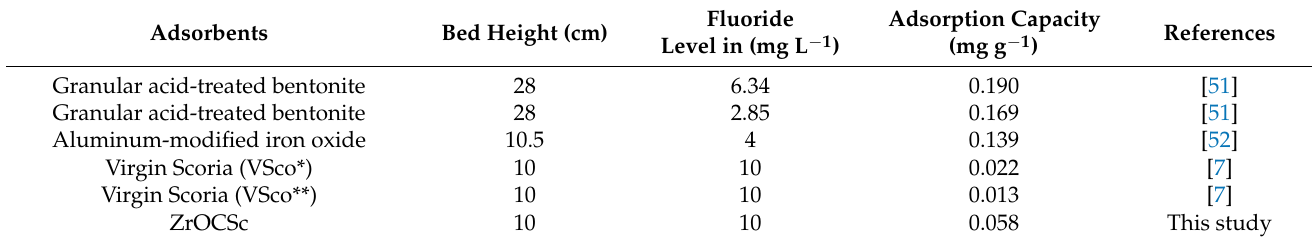
Table 5. Fluoride uptake capacity of some reported